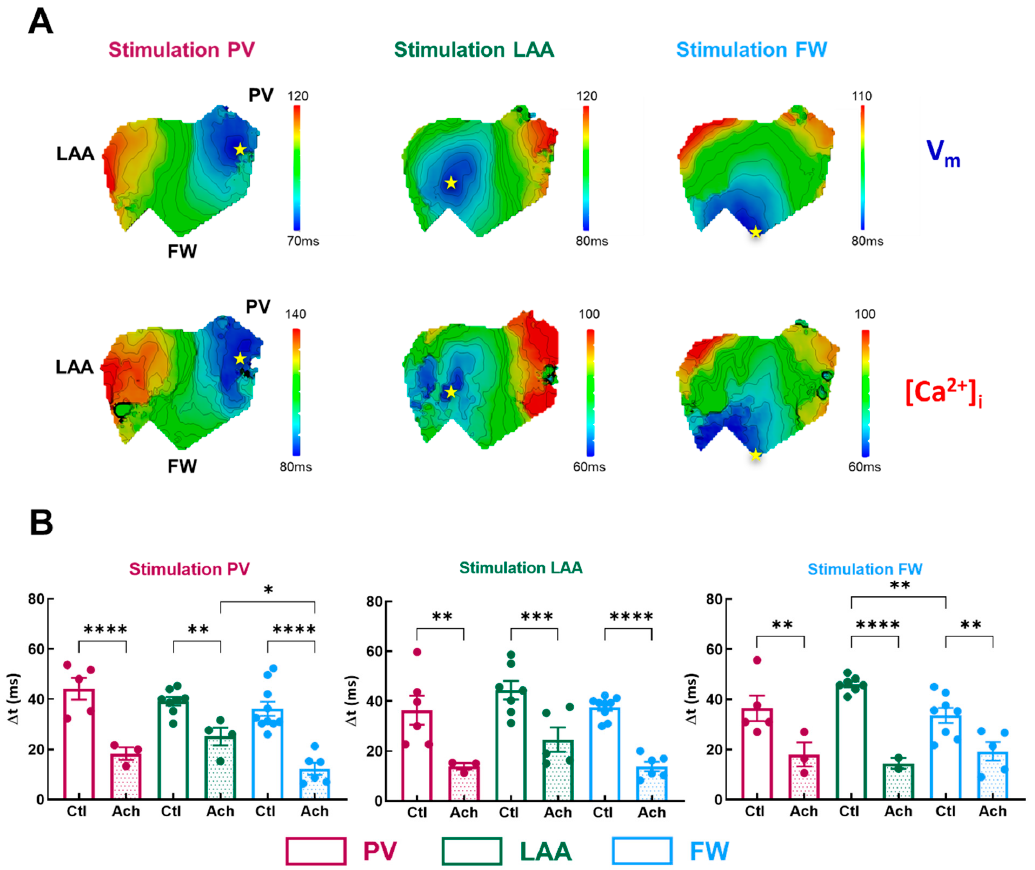
Figure 6. Temporal characteristics of [Ca] i -Vm relationship. ( A ) Representative activation map for Vm (top panel) and [Ca] i (lower panel) for three pacing sites (PV, LAA, FW, left to right). The site of stimulation is represented as a yellow star. ( B ) Mean data for V m -Ca 2+ delay ( Δ t) at three pacing sites (PV, LAA, FW, left to right) measured in three regions PV (purple), LAA (green), FW (blue) under control perfusion (Ctl, open bar) or after administration of acetylcholine (Ach, grey bar). N = 10; One-way ANOVA followed by a Tukey’s multiple comparison test * p < 0.05, ** p < 0.01, *** p < 0.001, **** p < 0.0001.